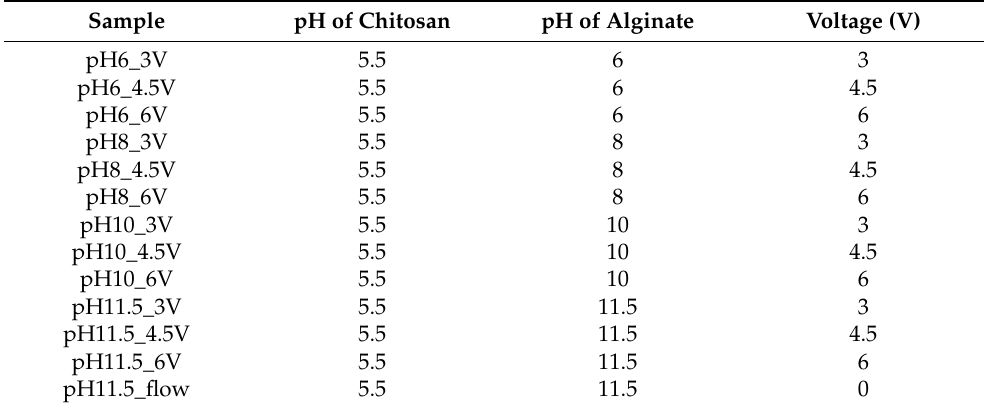
Table 1. Sample abbreviations with respect to the fabrication